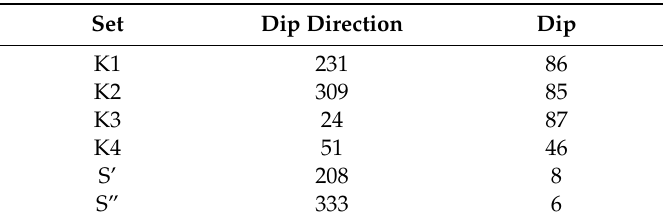
Figure 15. Stereoplot showing the comparison among the data from geo-structural analysis from point cloud and direct acquisition from standard geomechanical survey. 5. Discussion